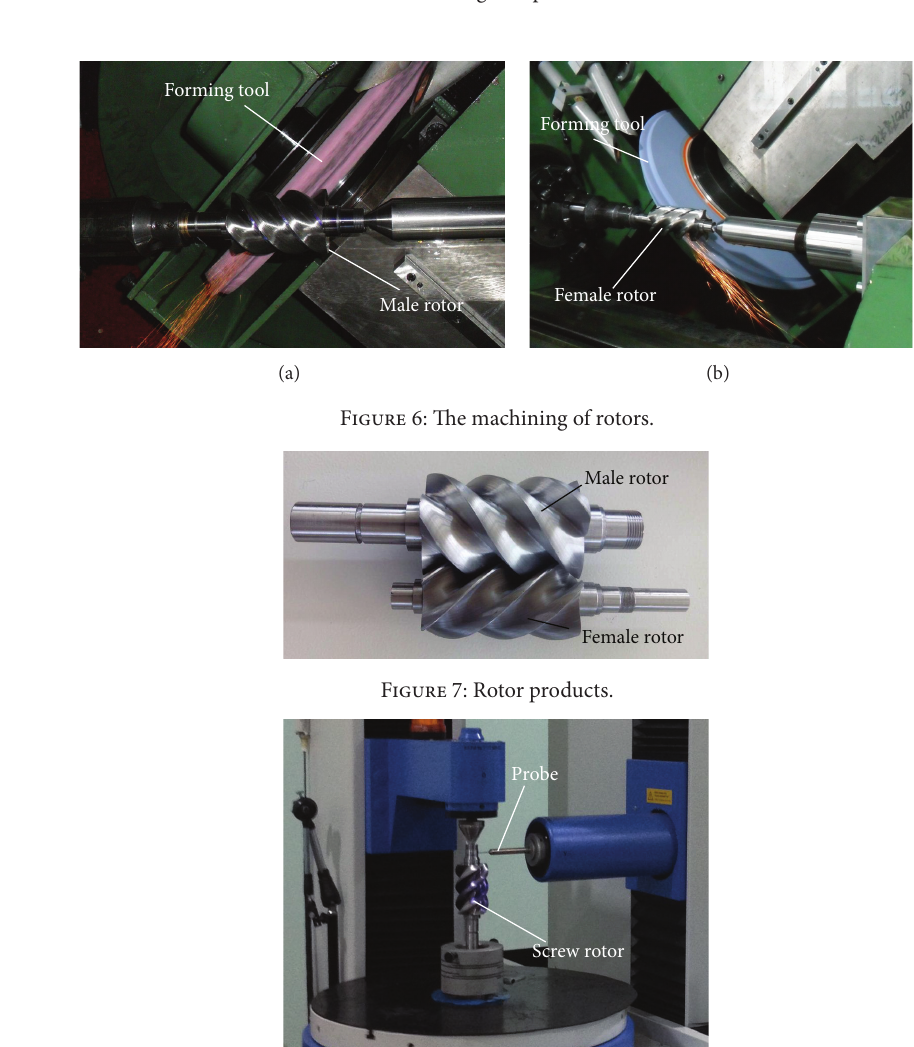
Figure 8: Measurement of